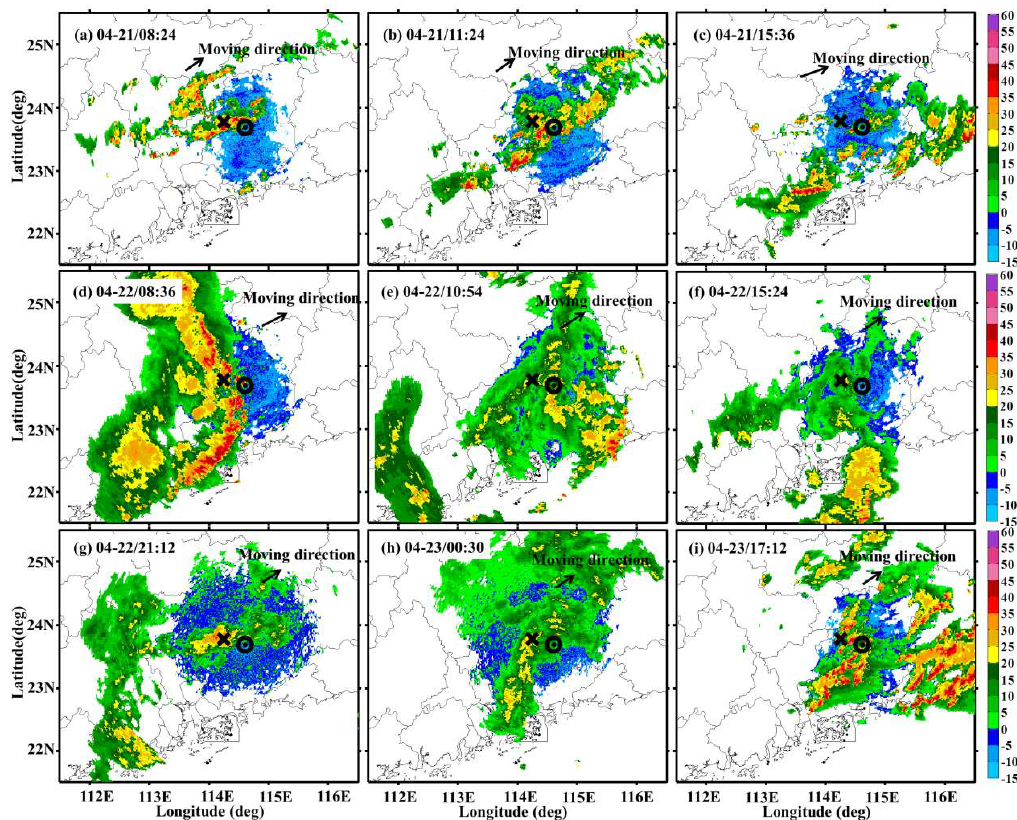
Figure 3. S-band radar combination reflectivity (CR) images of different convections between 21–23 April. ( a )–( i ) represent nine different moments. The circle represents the location of the Heyuan S-band radar, the cross represents that of the Longmen site.